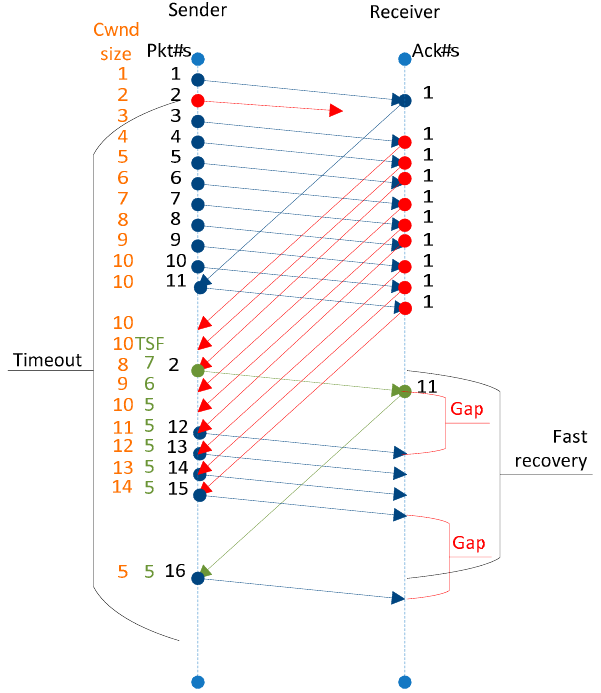
Figure 1. Illustration of fast-retransmit and fast-recovery algorithms.